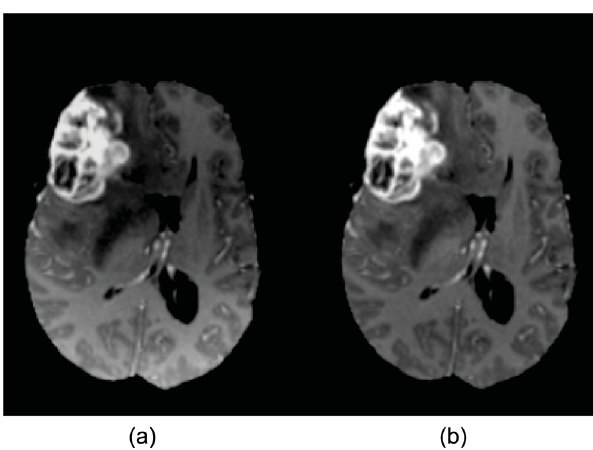
Fig. 2 An MRI scan (a) before and (b) after N4ITK bias field